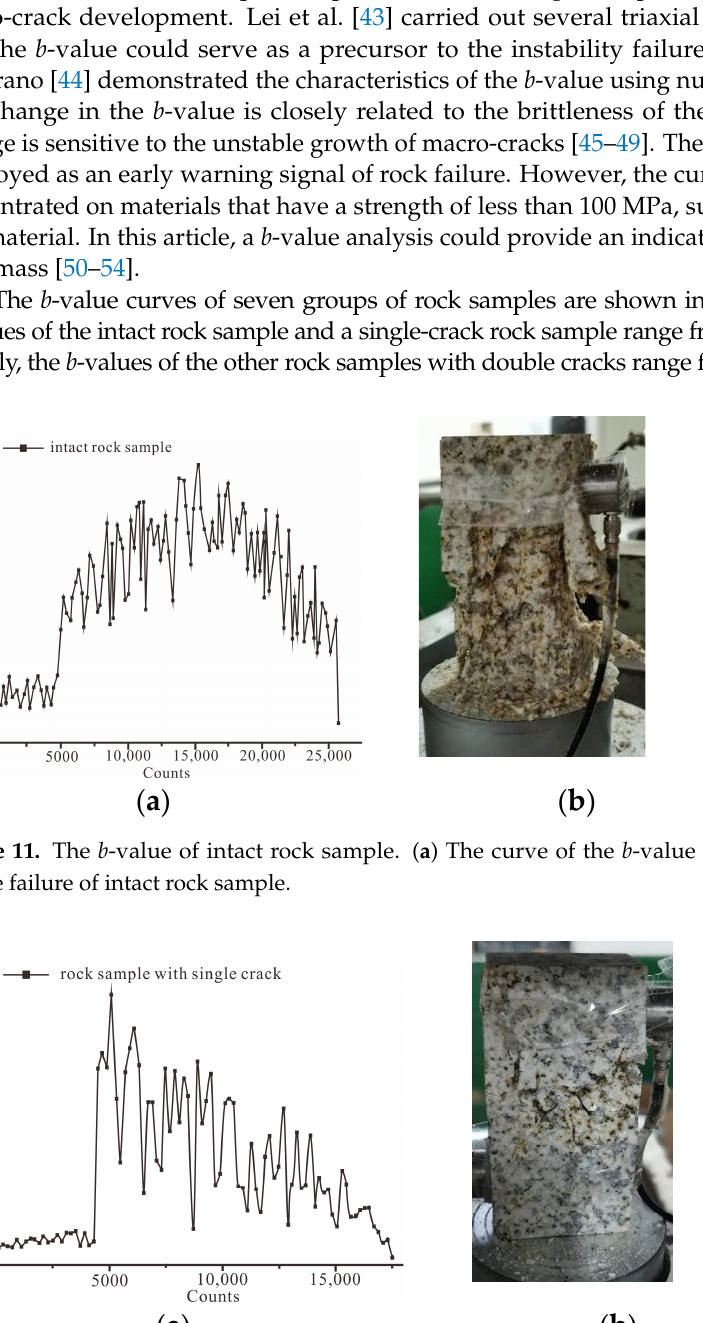
Figure 12. The b -value of the rock sample with a single crack. ( a ) The curve of the b -value of rock sample with single crack; ( b ) the failure of a rock sample with a single crack.